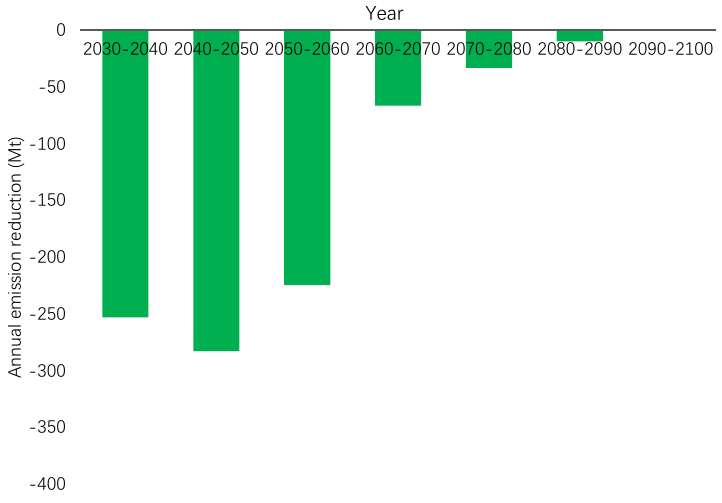
Figure 9. Annual emission reductions in industry sector from 2030 to 2100.